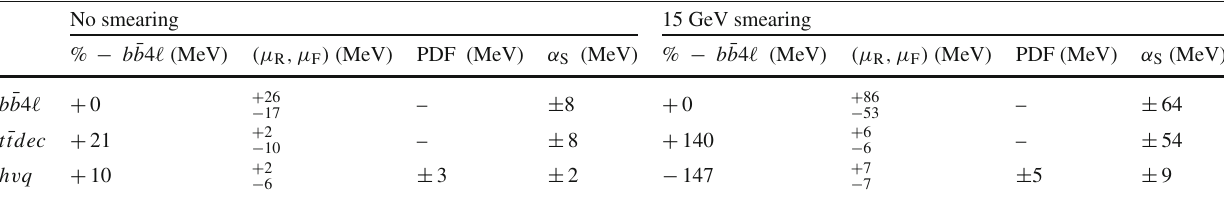
Table 6 Theoretical uncertainties associated with the m Wb peak position extraction for m t =172.5 GeV for the three different generators, showered j with Pythia8.2 . The PDF uncertainty on the b ¯ b 4 (cid:4) and t ¯ tdec generators is assumed to be equal to the h v q one, as explained in Sect. 6.1.2 No smearing 15 GeV smearing